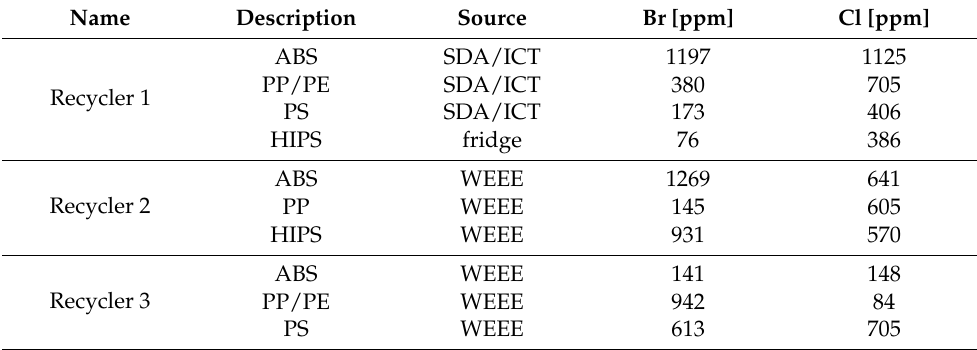
Table 4. Bromine and chlorine values of the recycled materials, which is produced on industrial scale by means of density